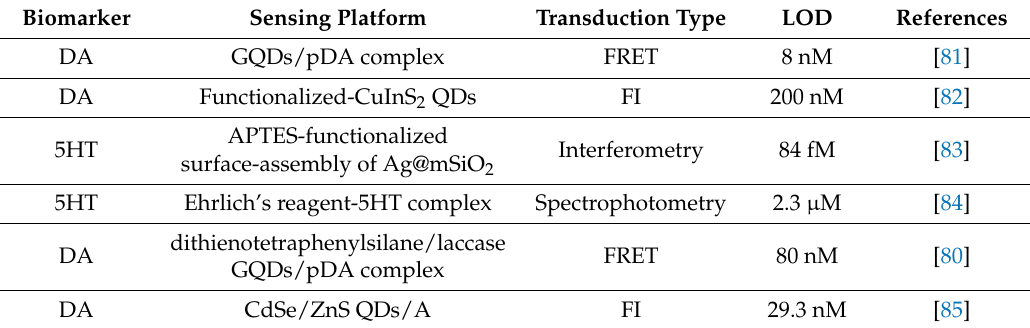
Table 2. Fluorescence-based biosensors and sensors for neurotransmitters determination. Biomarker